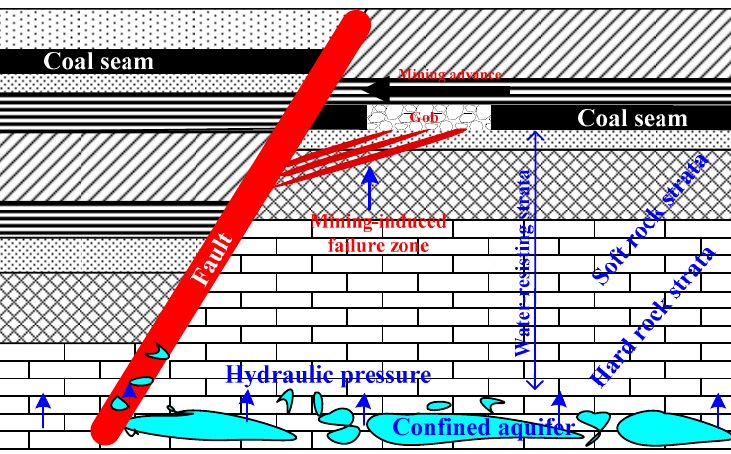
Figure 1. Influencing factors of water inrush from coal floor.